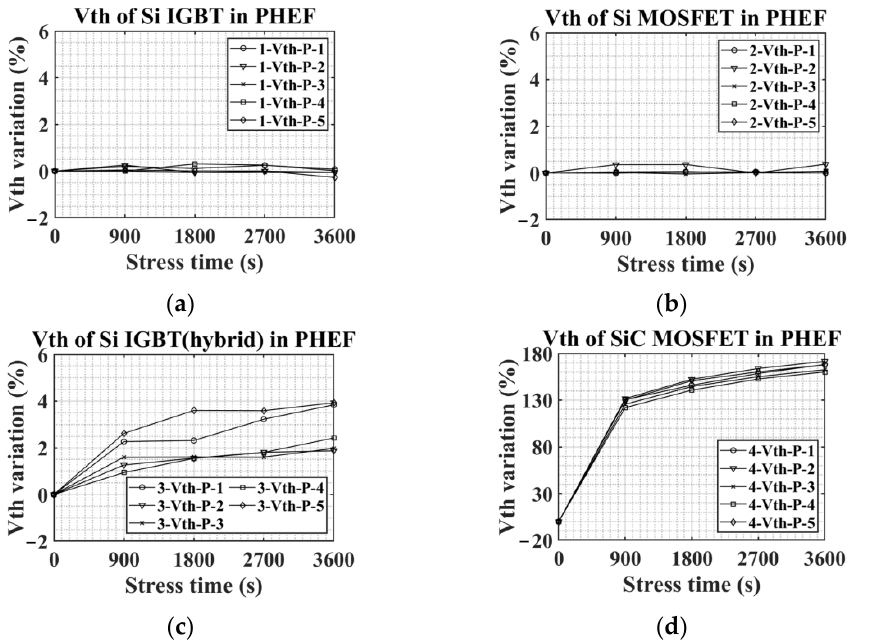
Figure 7. V th variations in PHEF stress: ( a ) Si IGBT, ( b ) Si MOSFET, ( c ) Si IGBT with SiC diode, and ( d ) SiC MOSFET.